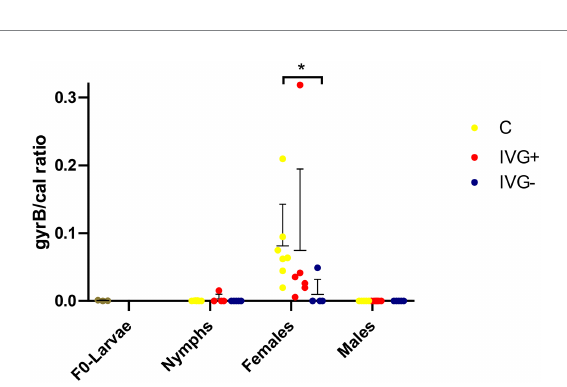
FIGURE 4 qPCR profiles (relative expression) of Midichloria mitochondrii . Each dot represents the relative gyrB expression in a single sample. The tick calreticulin gene was used as a housekeeping gene. Bars represent mean with the standard deviation shown in error bars. Statistical analysis by Mann–Whitney test performed in Graphpad. IVG + , in vitro feeding with gentamicin; IVG − , in vitro feeding without gentamicin; C, control feeding in vivo on calves. * p <